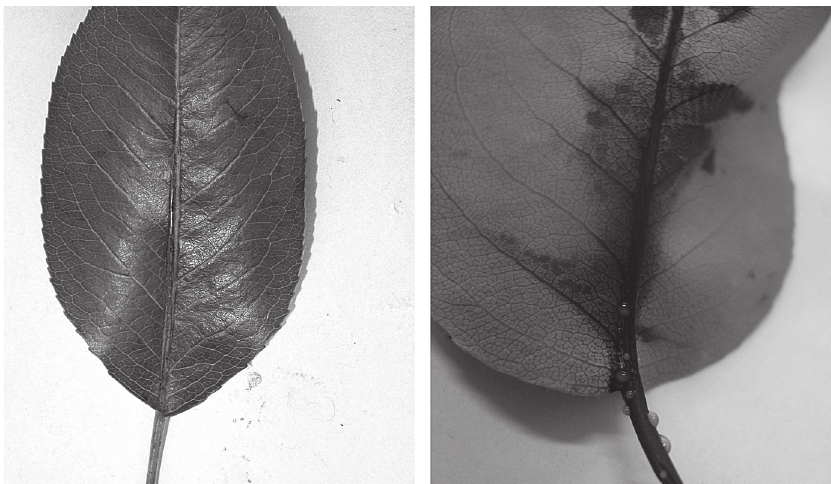
Figure 1. Pathogenicity induced by the inoculation of the tested isolates of Erwinia amylovora on pear leaves. Left, leaf inoculated with sterile distilled water (control). Right, symptoms and bacterial oozes on inoculated leaf.